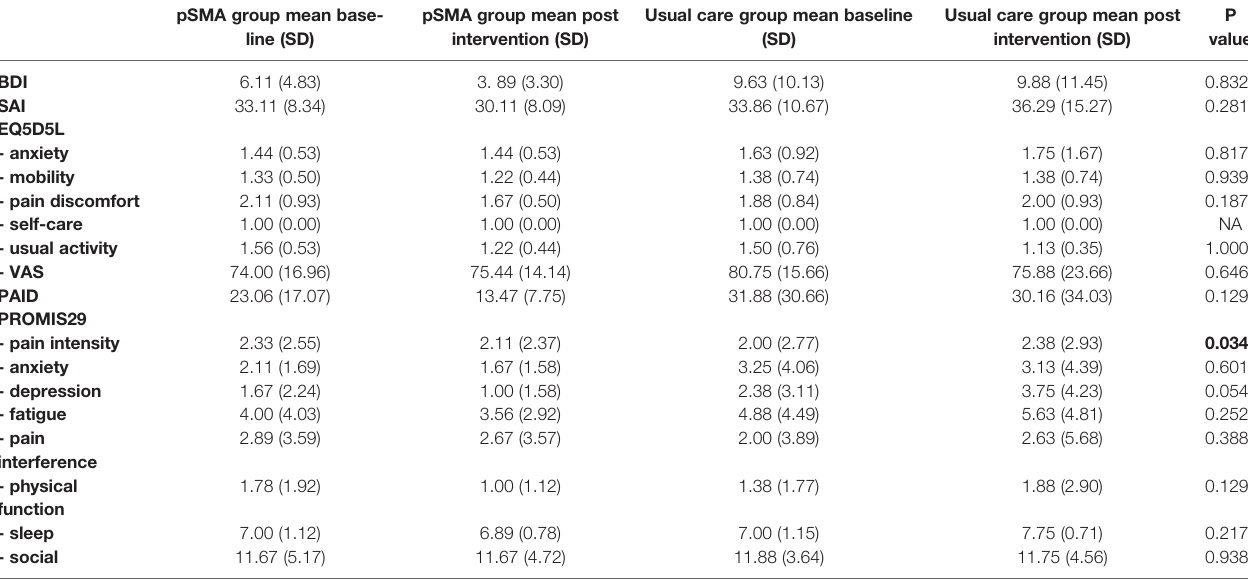
TABLE 7 | Psychological outcomes and quality of life at baseline and 12 weeks. pSMA group mean base- pSMA group mean post Usual care group mean baseline Usual care group mean post line (SD) intervention (SD) (SD) intervention (SD)